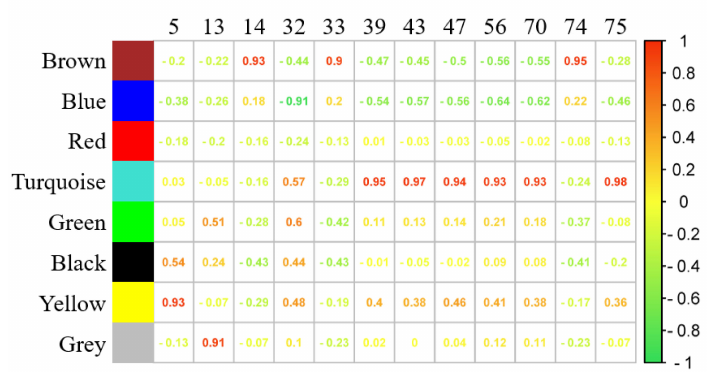
Figure 4. The high correlation among gene modules and several volatiles from WGCNA results. Colors stand for different gene modules. Compounds are labeled by numbers consistent with Tables S2 and